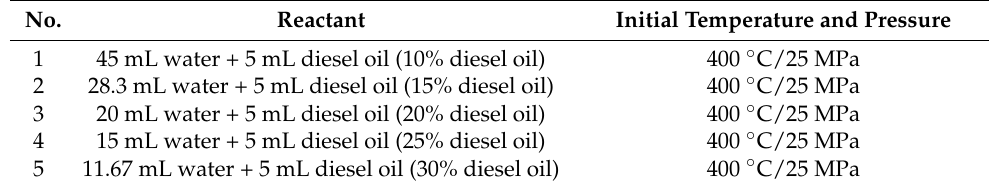
Table 2. Experimental parameters of supercritical water–diesel reactions to generate supercritical multi-thermal fluid under different oil–water